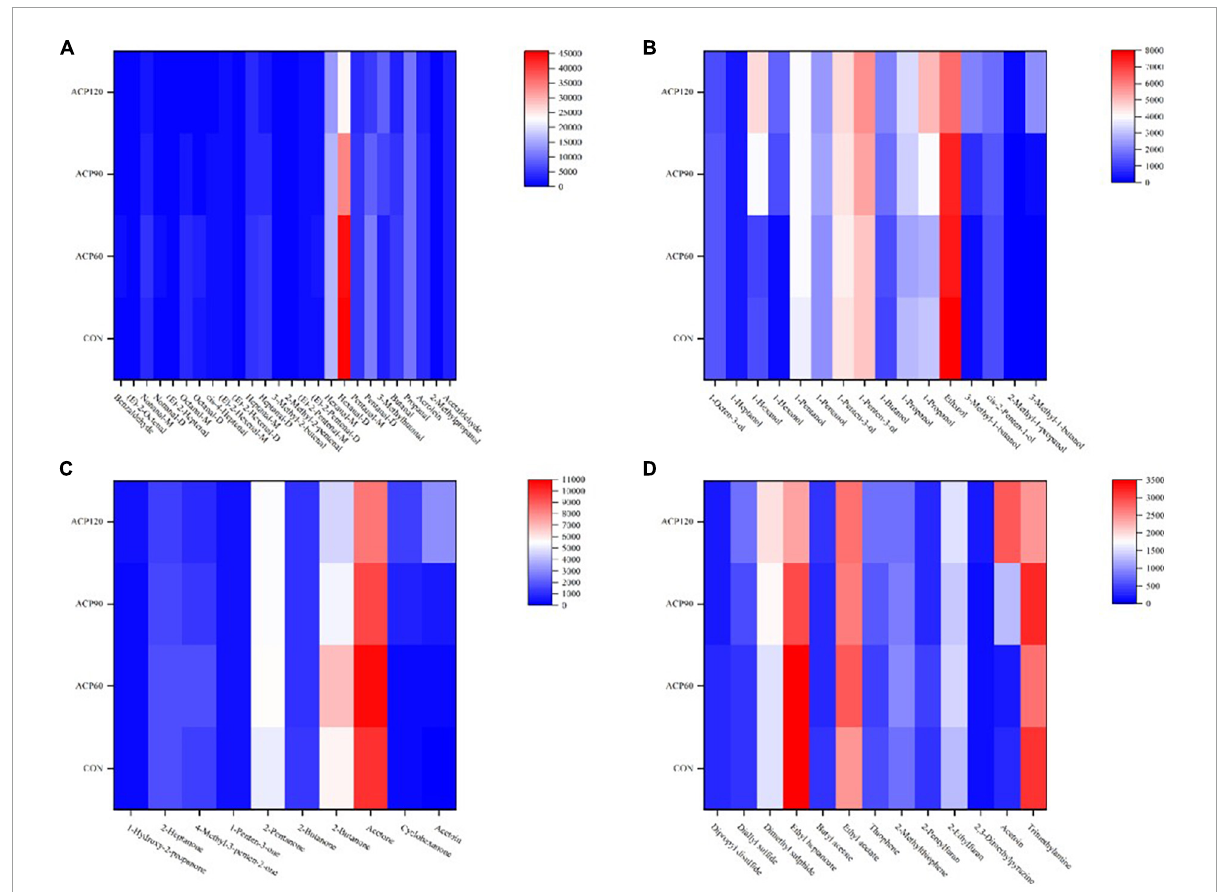
FIGURE6 The analysis of volatile organic compounds include aldehydes (A) , alcohol (B) , ketone (C) and Other classes (D) by heat map of surimi gels subjected to different treatment times. (CON, surimi gels without ACP treatment; ACP60, surimi gels treated with ACP for 60 s; ACP90, surimi gels treated with ACP for 90 s; ACP120, surimi gels treated with ACP for 120